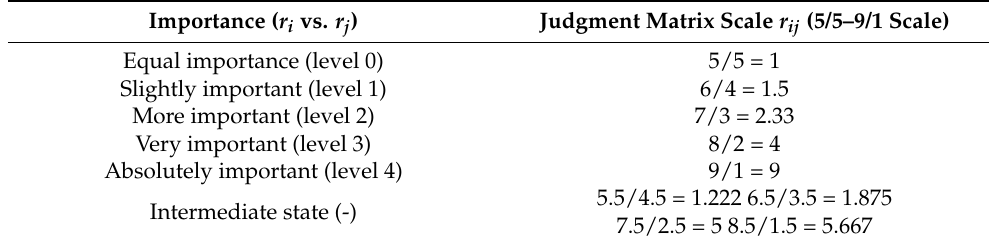
Table 10. Judgment matrix scale and its